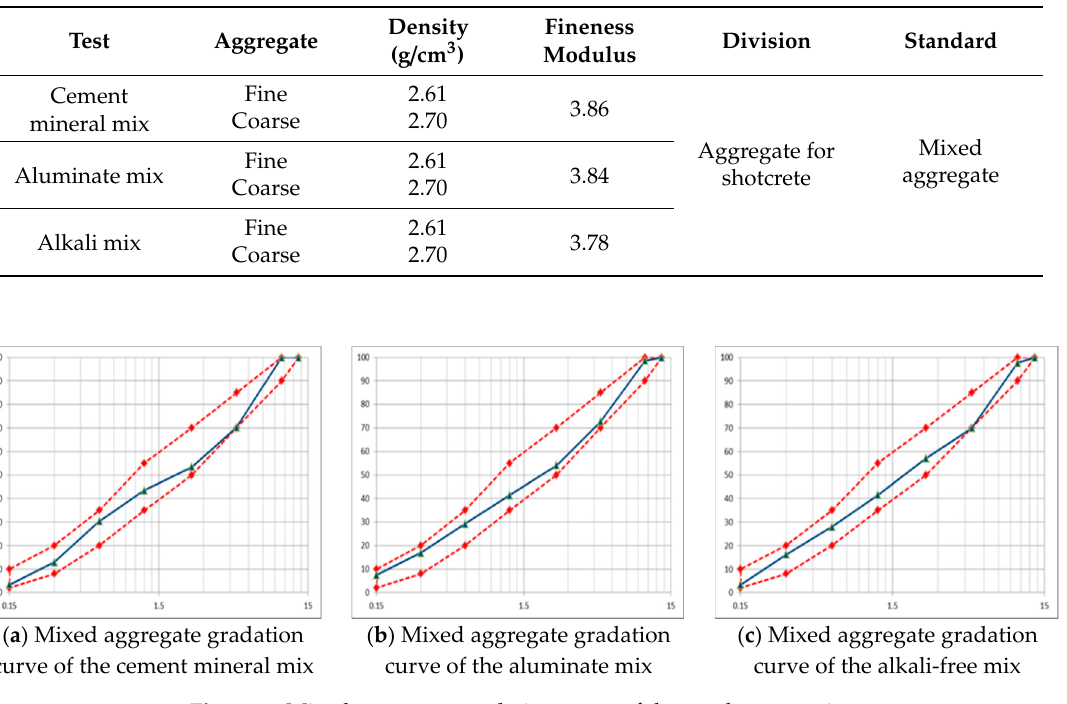
Figure 1. Mixed aggregate gradation curve of the accelerators mix.